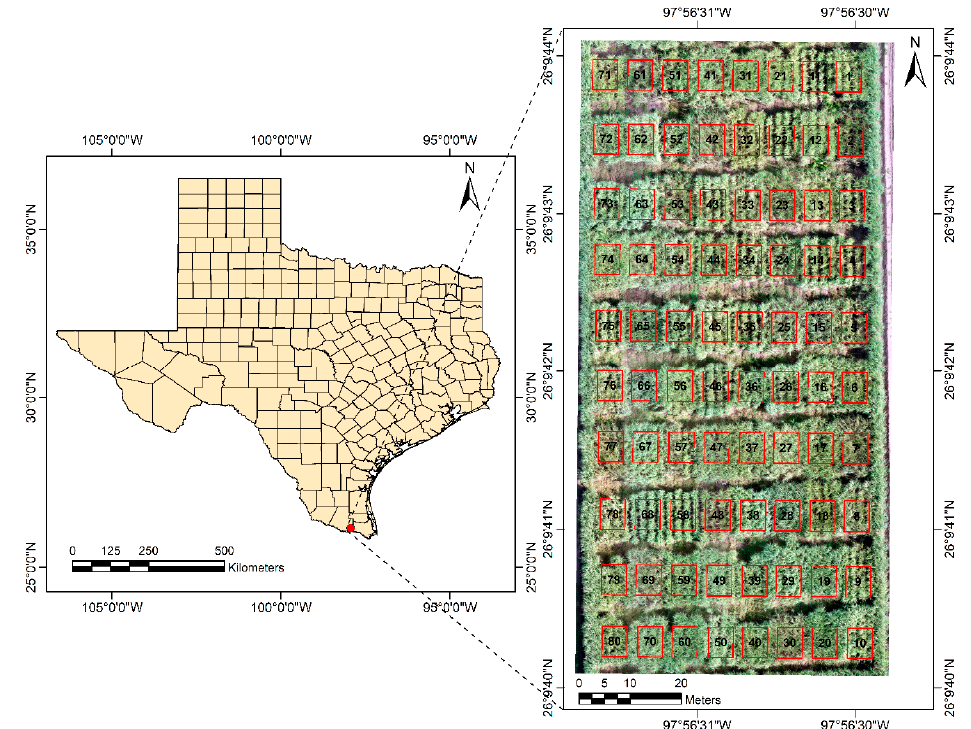
Figure 1. Study area location with the experimental plots.